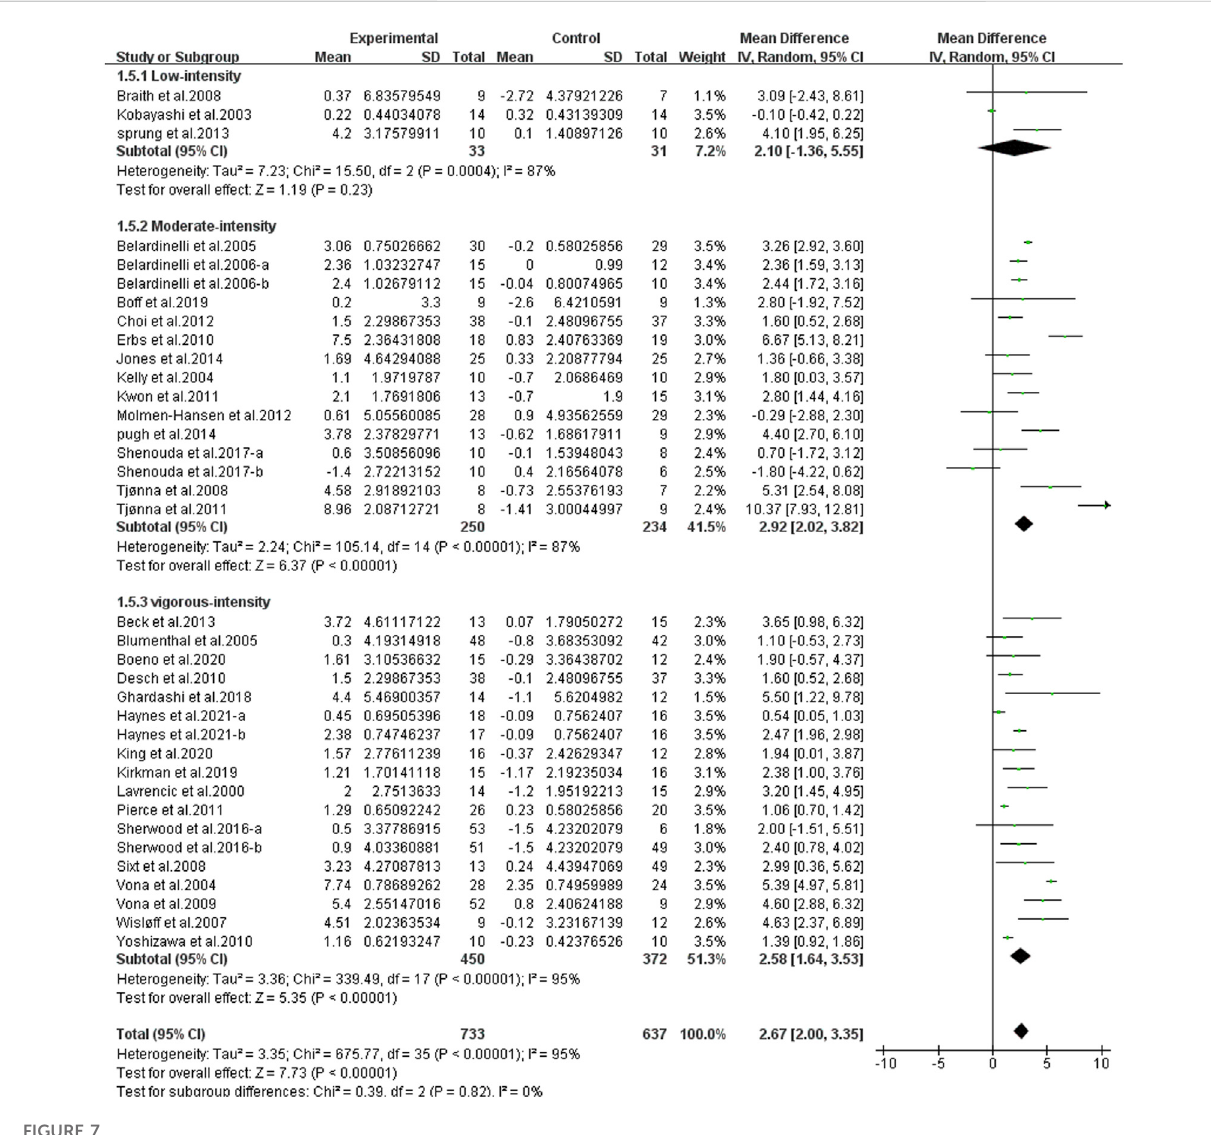
FIGURE 7 Meta-analysisresults oftheeffectofdifferentintensities ofcontinuous aerobic exerciseonFMD.Thepooledestimateswereobtained fromrandom effects analysis. Diamonds indicated the size of the effect of each study summarized as WMD. The size of the shaded square was proportional to the percentage weight of each study. Horizontal lines represented the 95% CI and the vertical dashed line represented the overall